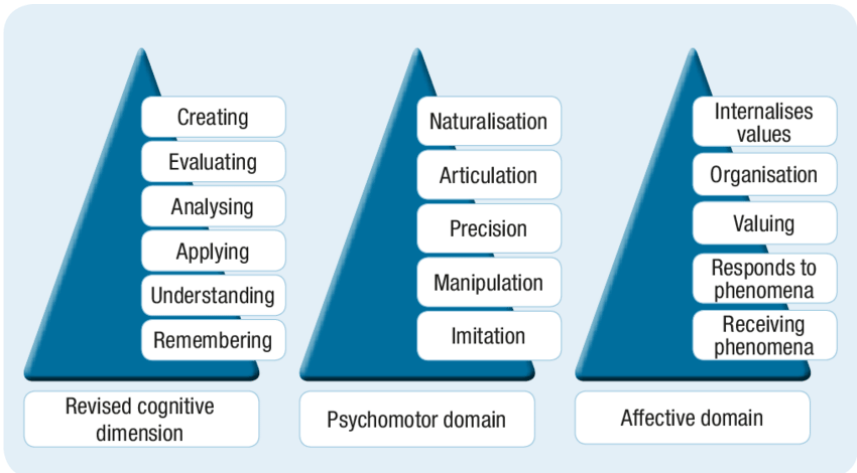
Figure 13. Elaboration of the experiential model of Kolb and Freitas (Source: Arnab S. et al., 2015. Mapping learning and game mechanics for serious games analysis, 2015).